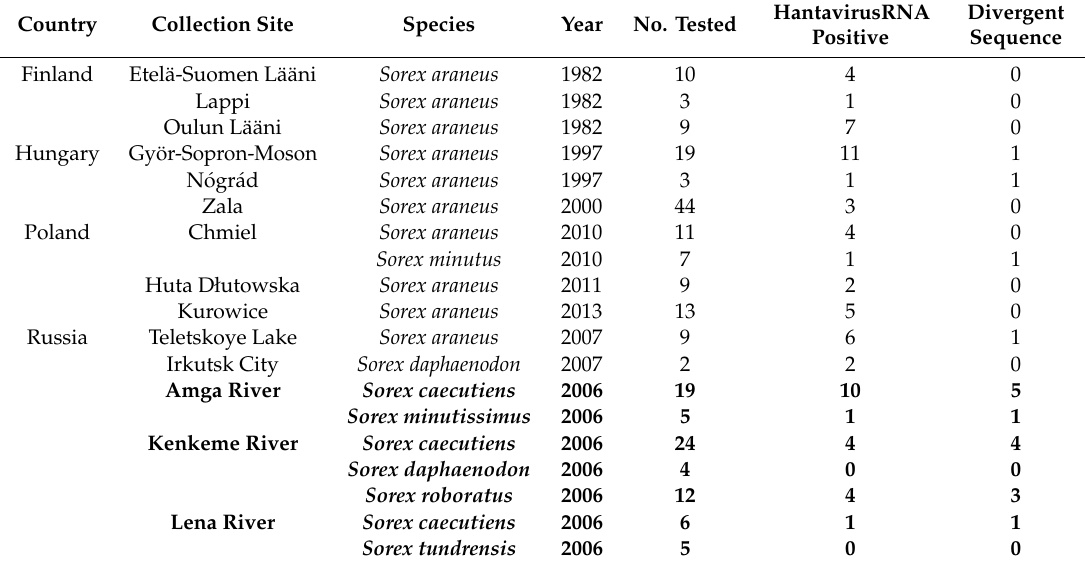
Samples for the present study are shown in bold type.